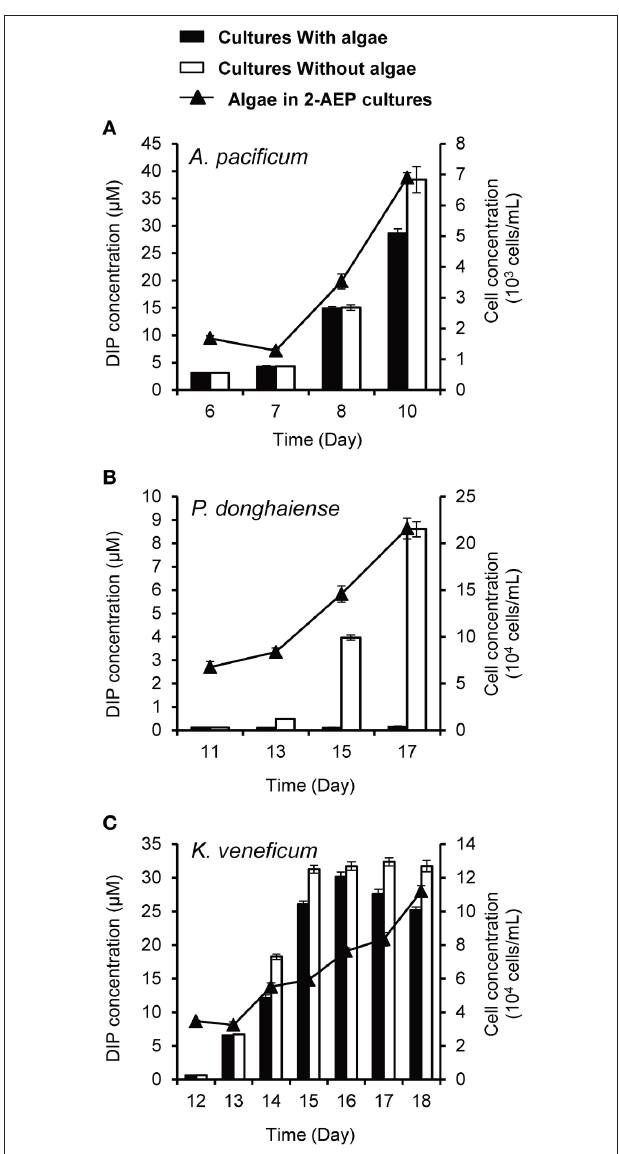
FIGURE 4 | DIP concentrations in the cultures with (solid bars) and without algae (open bars) as well as growth curves of the dinoflagellates A. pacificum (A), P. donghaiense (B), and K. veneficum (C) in the normal cultures grown in 2-AEP amended medium (solid triangles and